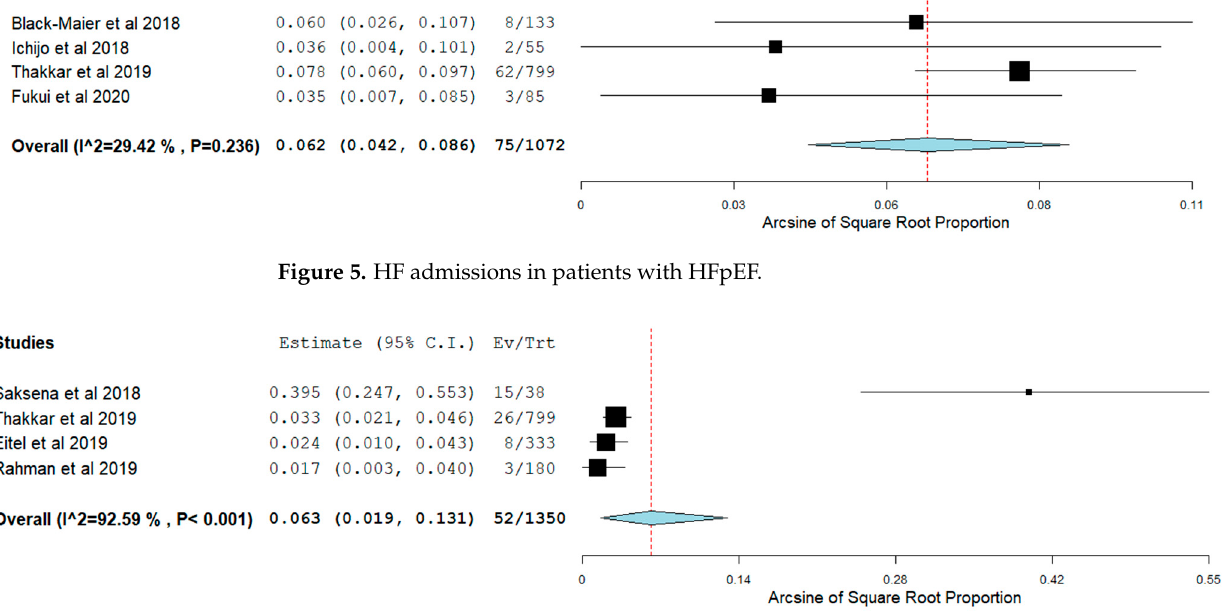
Figure 6. All-cause mortality in patients with